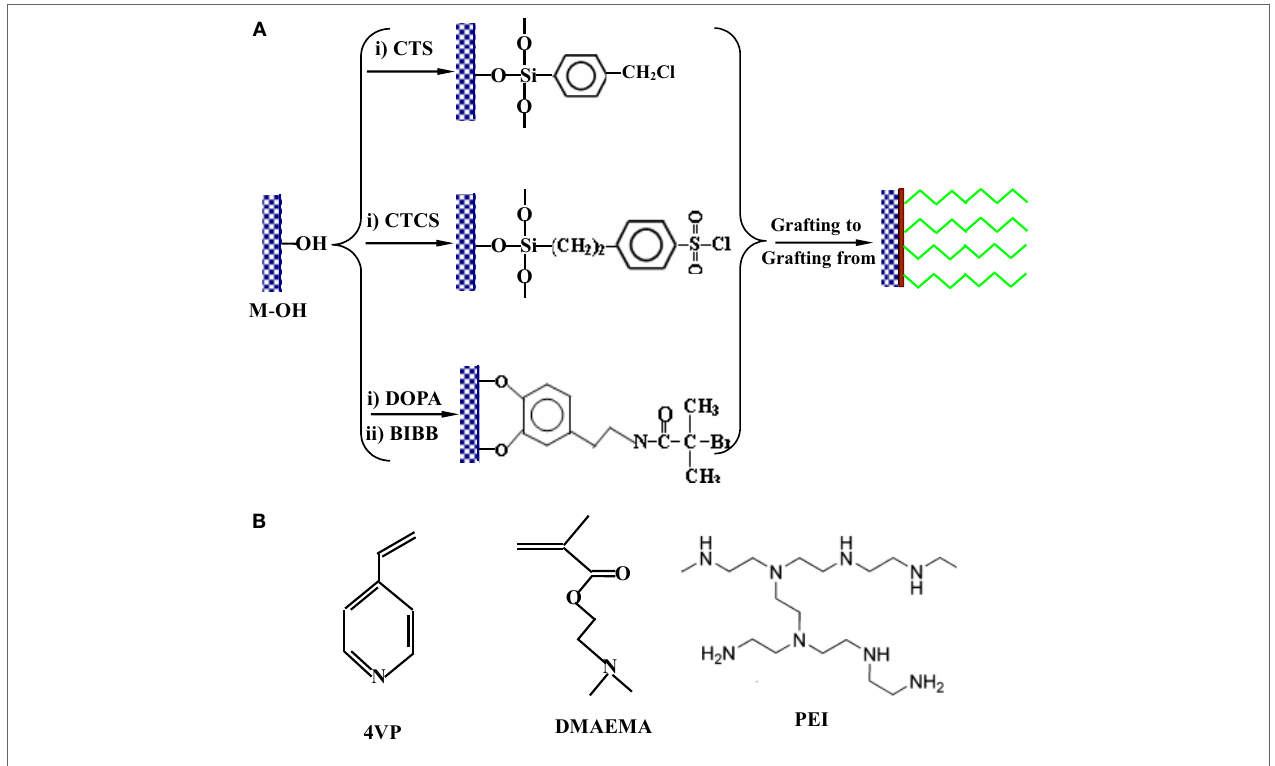
FiGURe 3 | (A) Methods of immobilizing surface-initiators on metal surface for the preparation of functional polymer coatings by “grafting to” approach, free-radical polymerization, and atom transfer radical polymerization [CTS: 4-(chloromethyl)phenyltrichlorosilane (Yuan et al., 2009a,b,c, 2010a), CTCS: 2-(4-chlorosulfonylphenyl)ethyl trichlorosilane (Yang et al., 2014), BIBB: 2-bromoisobutyrate bromide]. (B) Molecular structures of 2-dimethylaminoethyl methacrylate (DMAEMA), 4-vinyl pyridine (4VP), and poly(ethyleneimine) (PEI) used in synthesis of antibacterial surfaces.